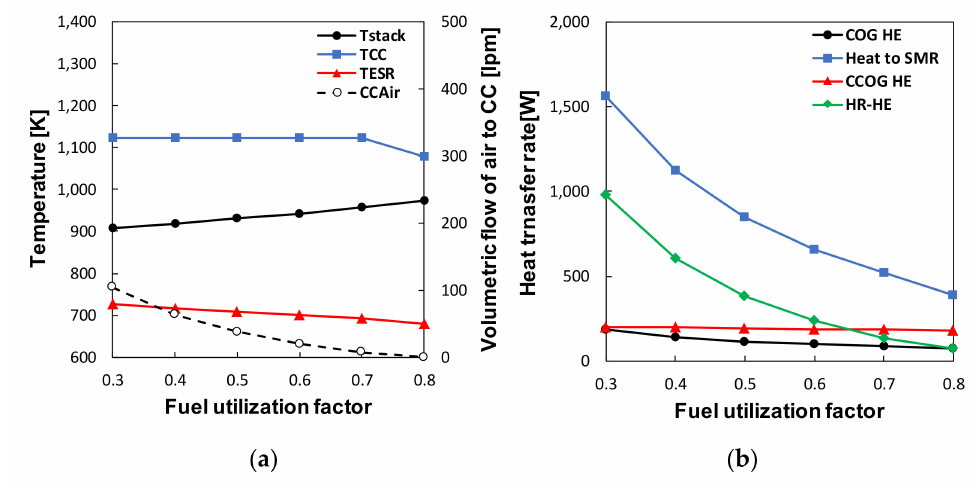
Figure 3. The effect of fuel utilization factor on the reference system; ( a ) temperature of each component, ( b ) heat transfer rate at each heat exchanger (COG HE: steam generator, CCOG HE: air pre-heater, HR HE: heat recovery heat exchanger).